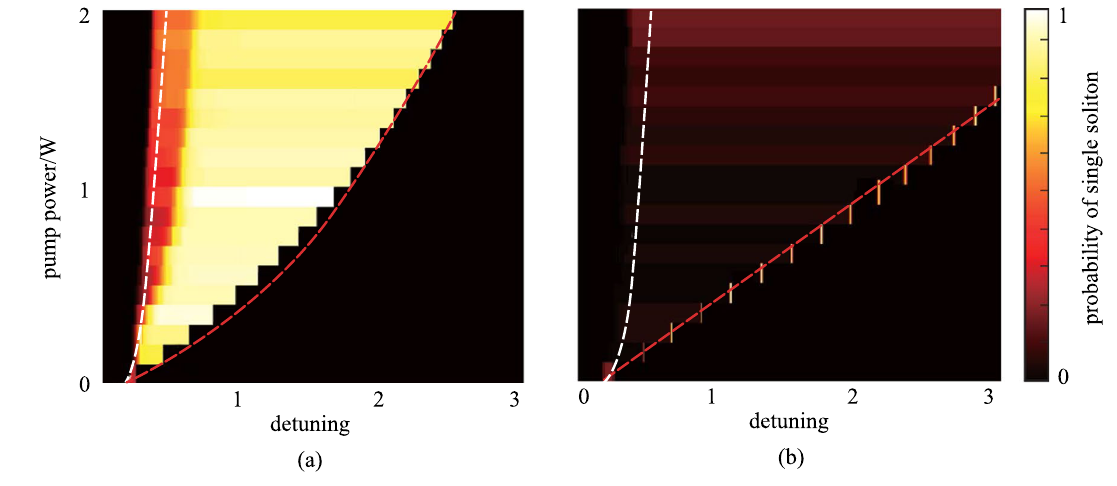
Fig. 7 Probability of single soliton generation with different combinations of pump-resonance detuning and pump power a with and b without filtering. The bifurcation boundaries determined by equilibria of GLLE are also given. White/red dashed lines represent the upper/lower bound- ary of the bright soliton region determined by Eqs. (8a) and (8b). Parameters used in a and b are the same as in Fig. 5b-iii and in Fig. 4c. In a , the lumped filtering induced energy dissipation coefficient is C = 2.7 × 10 −